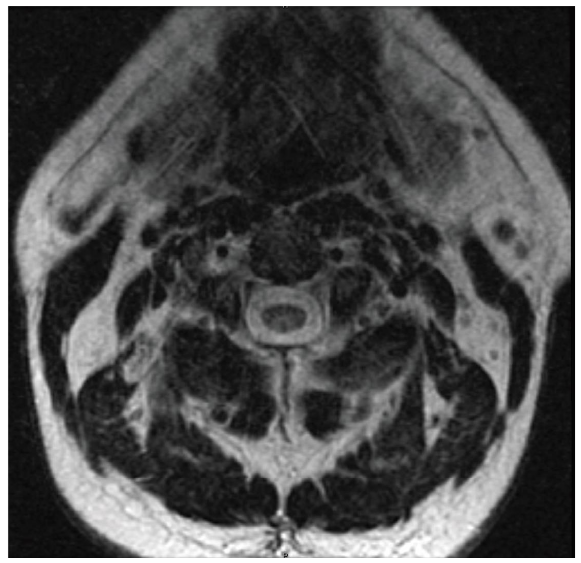
Figure 3: MRI of the cervical spine showing abnormal signal in the posterior